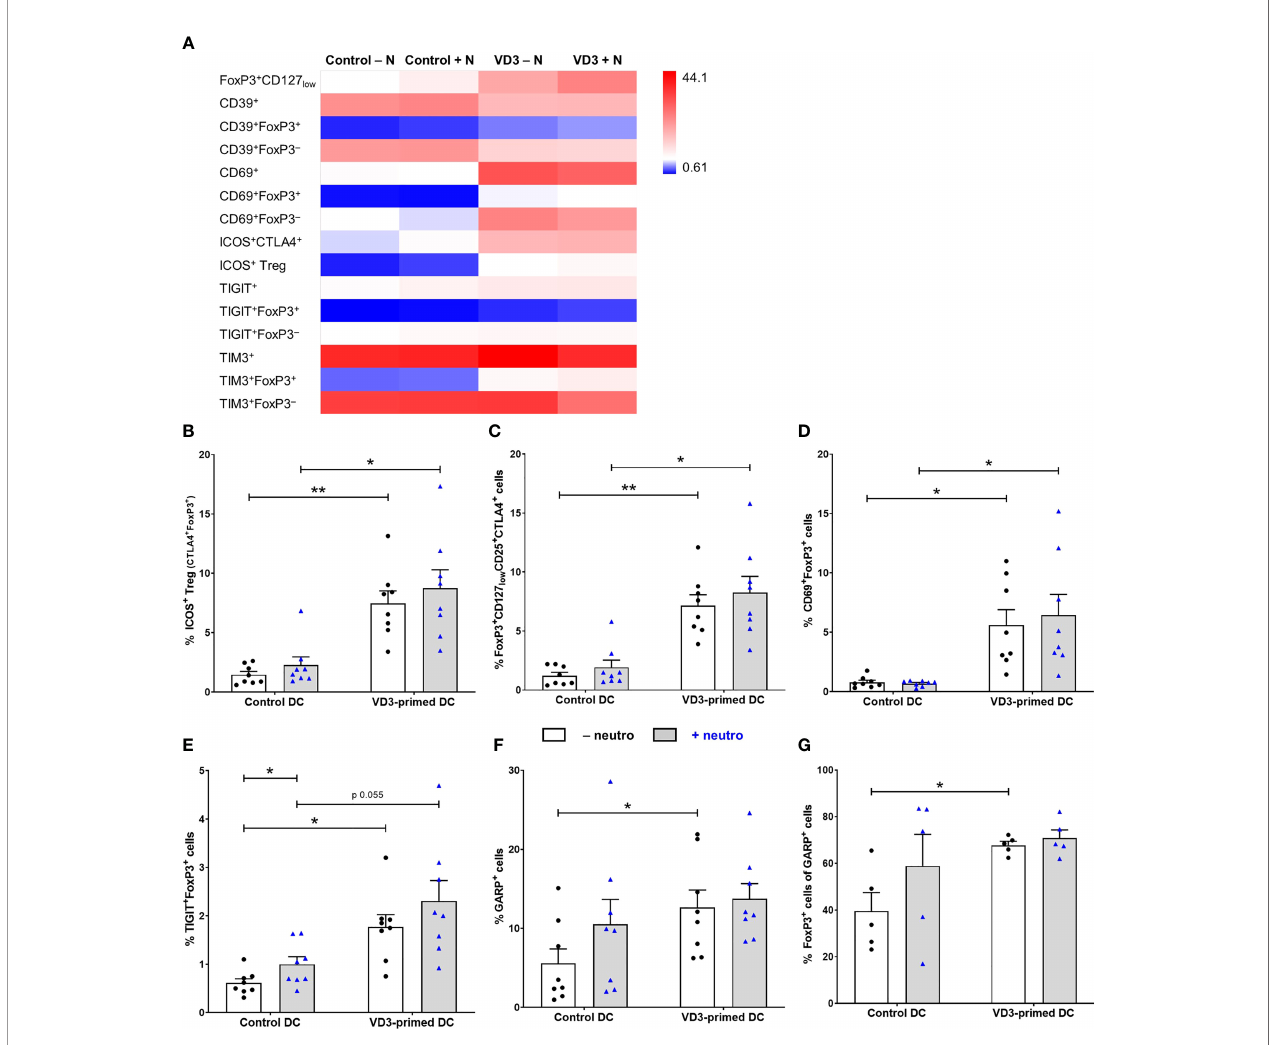
FIGURE 3 | Tregs generated by VD3-primed DCs express functional markers even in the presence of neutrophils. (A) Heatmap showing the mean frequency of indicated cell populations gated on single cells of T cells measured on day 11 of control or VD3-primed DC conditions in the absence or presence of neutrophils of eight independent experiments. (B) The percentage of ICOS + Tregs is depicted, expressing CTLA4 and FoxP3 in addition to ICOS ( n = 8). (C) The percentage of FoxP3 + CD127 low CD25 + CTLA4 + T cells is shown. (D) The percentage of CD69 + FoxP3 + T cells is depicted. (E) The percentage of TIGIT + FoxP3 + T cells is shown. (F) The percentage of GARP + T cells is depicted after 24 h of restimulation with a CD3 and a CD28 ( n = 8). (G) The percentage of FoxP3 + cells in GARP + T cells is shown ( n = 5). Bar graphs show mean ± SEM. One-way ANOVAs with Holm – Sidak ’ s post hoc test were performed. * p < 0.05, ** p <